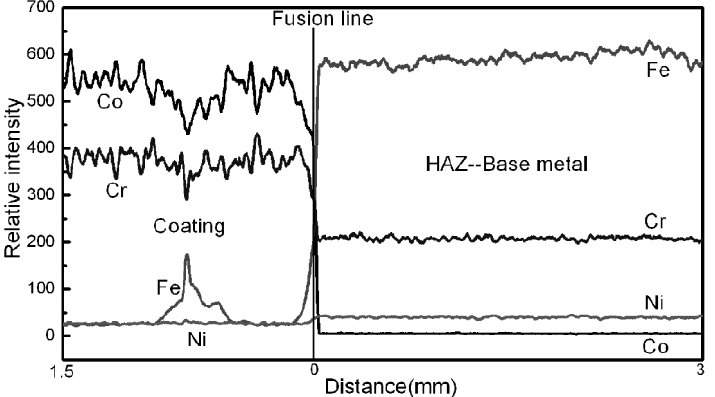
Figure 4. The observation of major element (Co, Fe, Cr, Ni) diffusion from coating to base metal by electron probe microanalysis